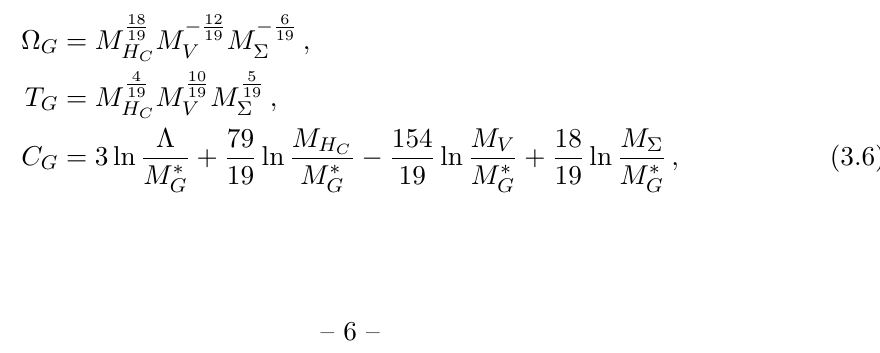
table 1. By plugging the masses and (cid:12) -function coe(cid:14)cients into the formula (2.13), we